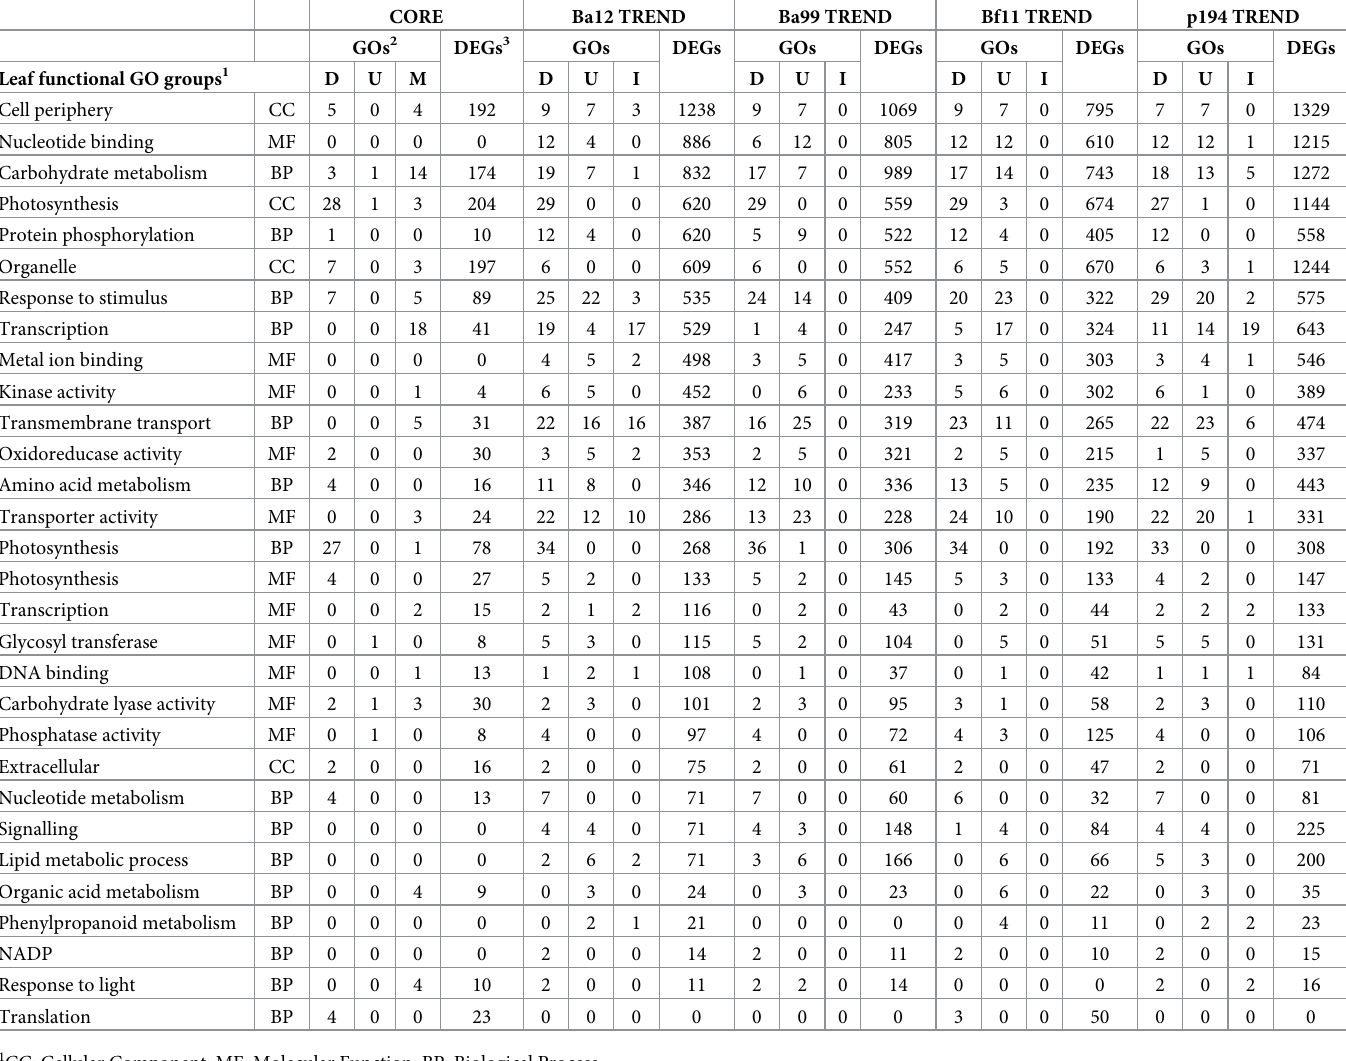
Table 2. The number of significantly enriched GO terms and total numbers of associated DEGs assigned to putative functional areas in the leaf for the core and trend